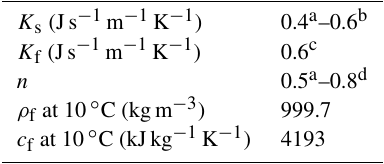
Table 2. Parameters within the 1-D heat transport equation de- rived by Turcotte and Schubert (1982) and modified by Schmidt et al. (2007). K s is the thermal conductivity of the solid, K f is the ther- mal conductivity of the fluid, and n is the porosity of the matrix. The density of the fluid and heat capacity of the fluid multiplied together are the volumetric heat capacity of the fluid ( ρ f c f , Jm − 3 K − 1